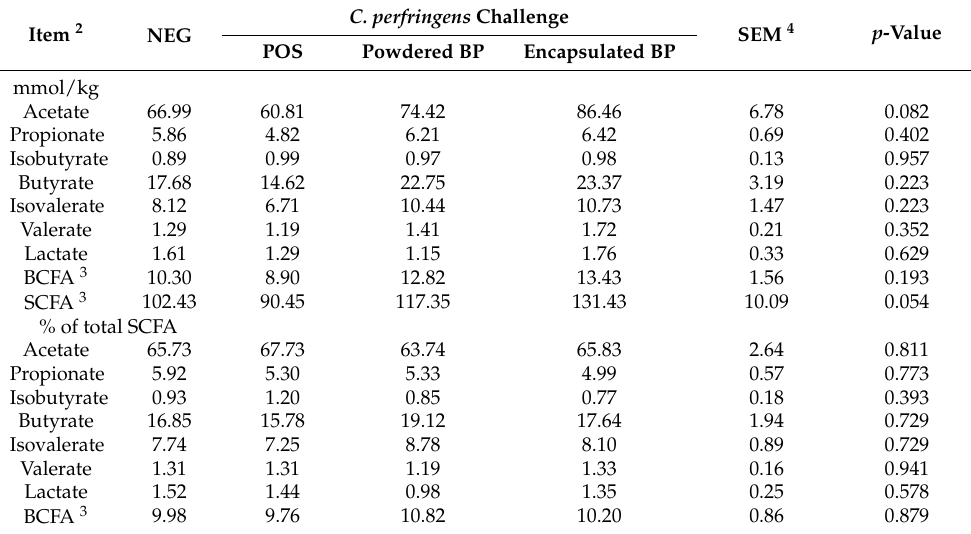
Table 5. Effects of dietary encapsulated and powder BPs on the absolute or relative concentrations (mmol/kg digesta, % of total) of cecal short-chain fatty acids (SCFA) in broiler chicken challenged with C. perfringens 1